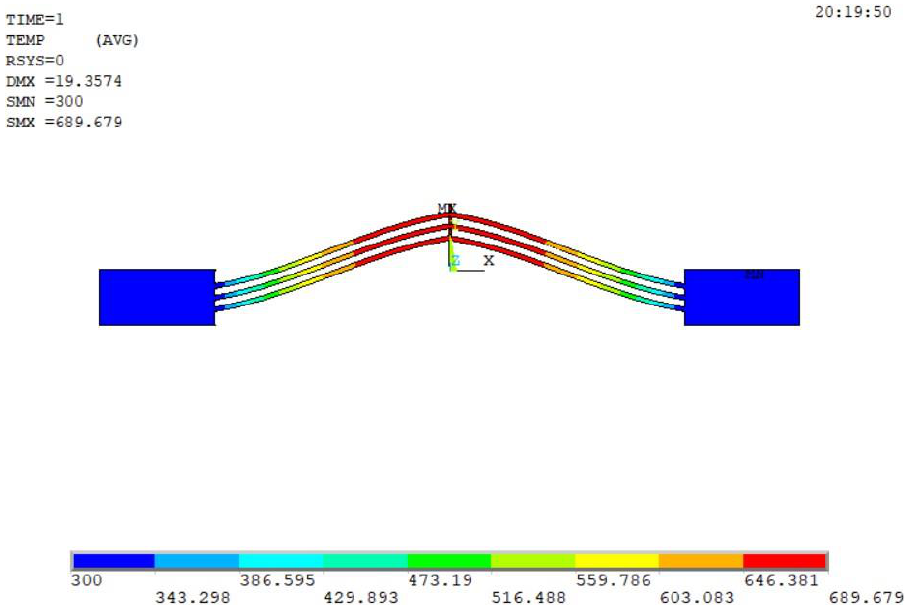
Figure 3. Simulation model of V-shaped electro-thermal actuator.